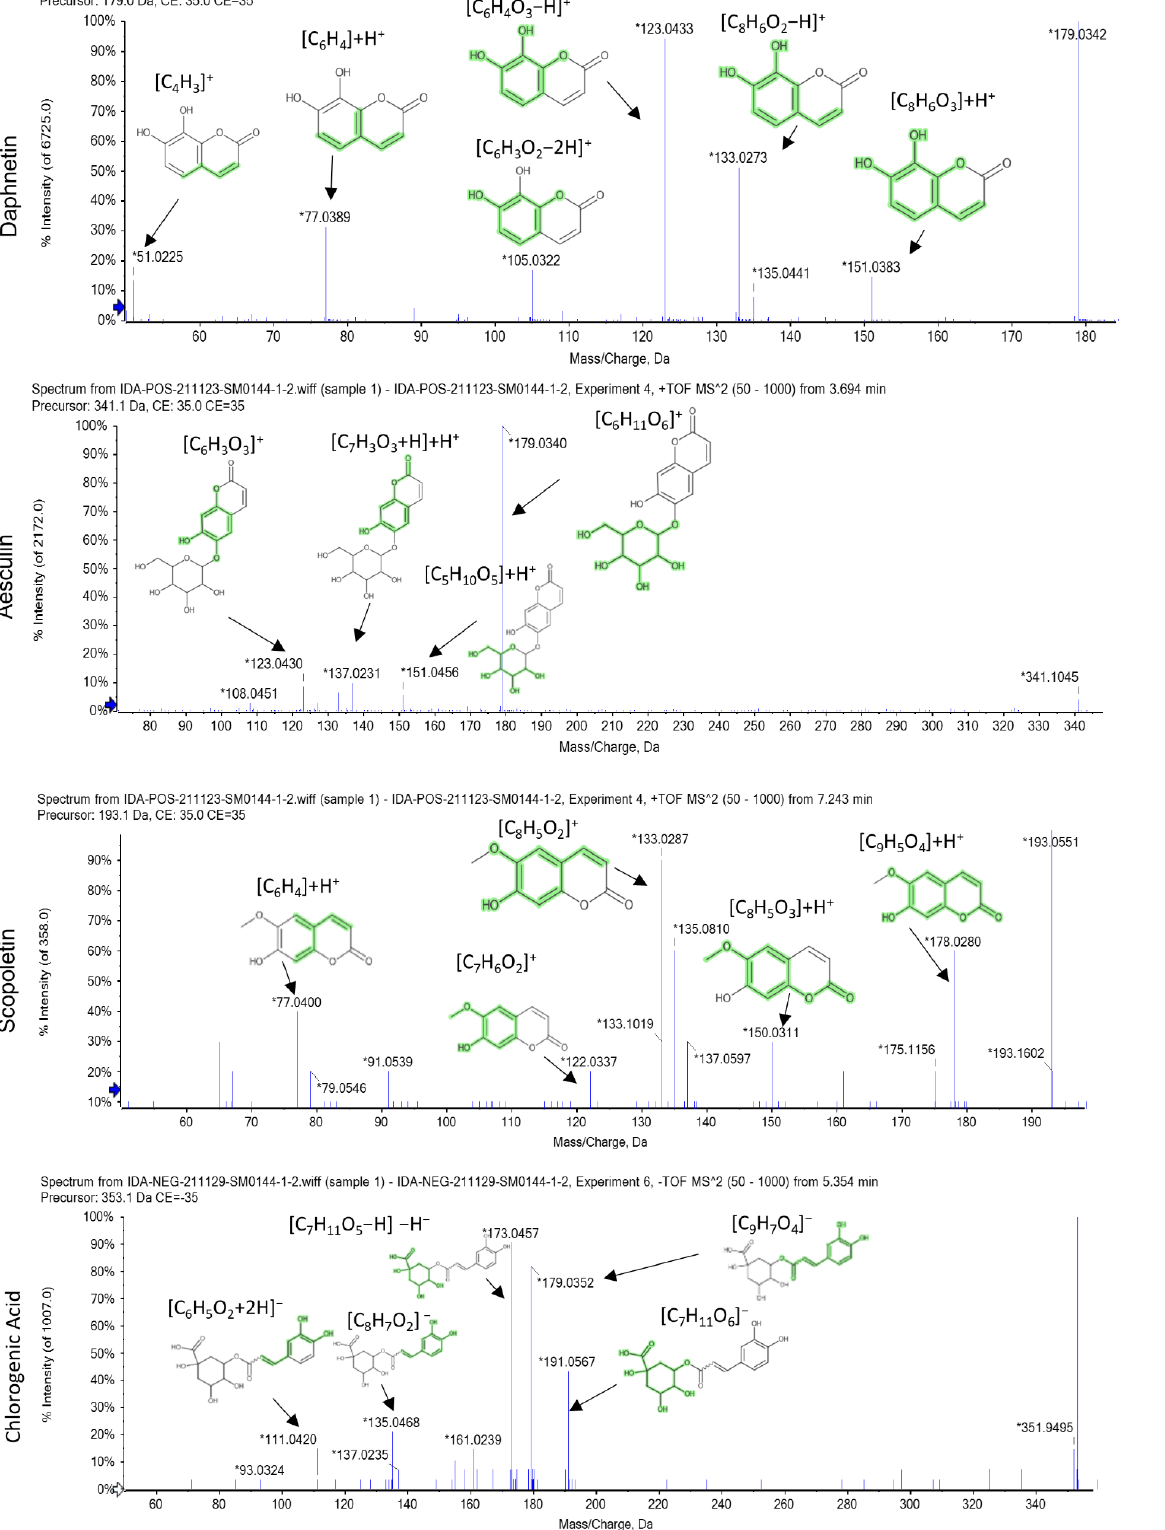
Figure 1. Mass/Mass spectra showing fragmentation pattern of major identified